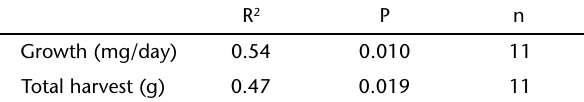
) after 20 days 38